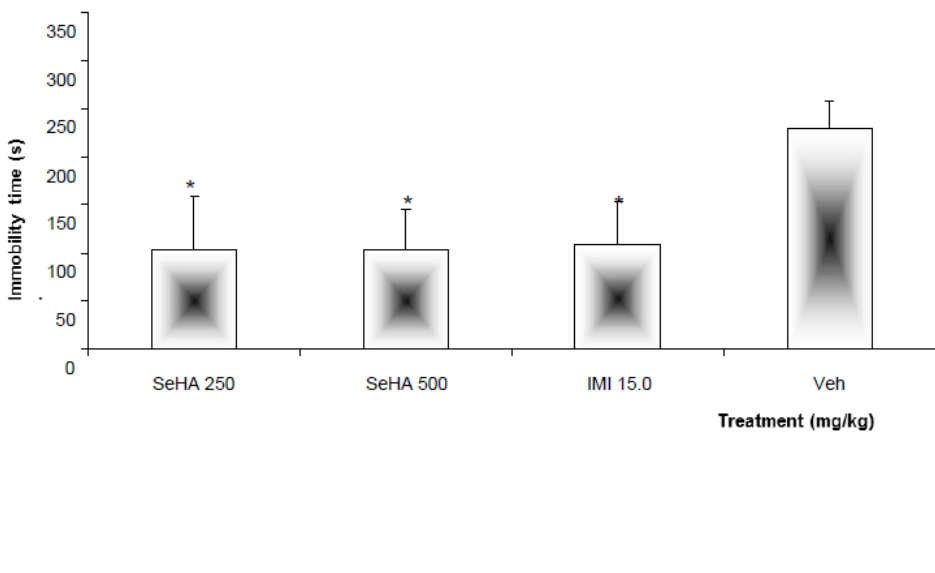
Figure 1. Effect produced by oral administration of the Salvia elegans hydroalcoholic extract (SeHA, 250 and 500 mg/kg) and comparison with the treatment with Imipramine (IMI, 15 mg/kg) and Vehicle (Veh, 1.0% Tween [TW] 20) on immobility time in FST. Statistical analysis was carried out with Analysis of variance (ANOVA) followed by the post hoc Dunnett test ( n = 8: mean ± standard deviation [SD]) (* p <